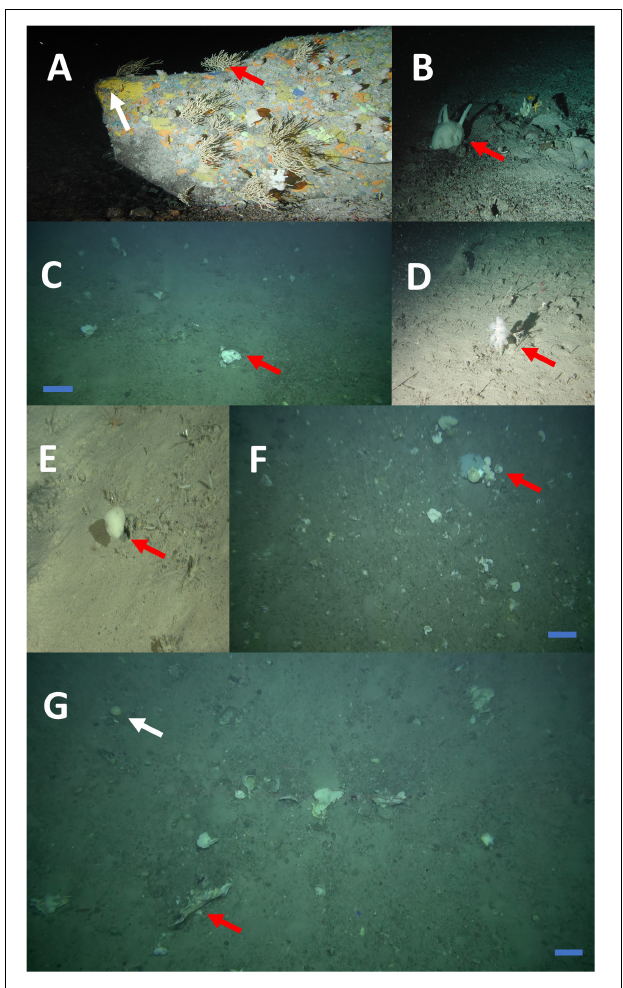
FIGURE 2 | Categories of sponge morphotypes from the Faroe-Shetland Channel Nature Conservation Marine Protected Area (FSC NCMPA). Category 1: encrusting ( A , white arrow), Category 2: arborescent (“tree-like”) ( A , red arrow), Category 3: massive (C) , spherical ( G , white arrow) and papillate (B) . Category 4: flabellate (“fan-shaped”) ( G , red arrow) and caliculate (“cup-shaped”) (F) . Category 5: stipitate (“stalked”) (E) and clavate (“club-shaped”) (D) . All scale bars: 30 cm. See also Table 2